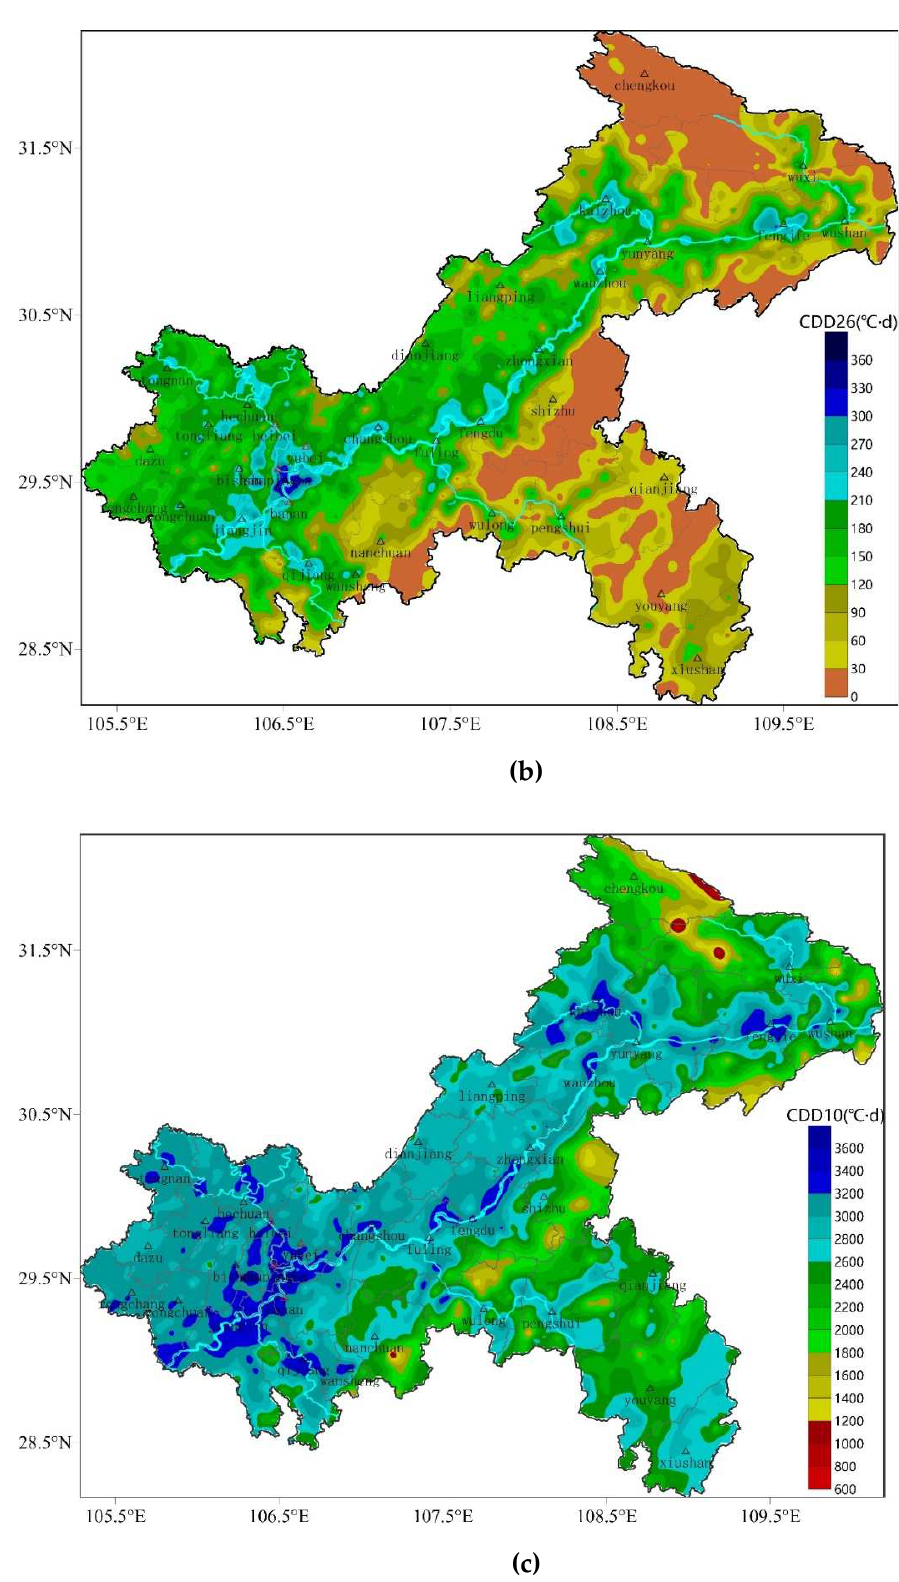
Figure 2. Refined spatial distribution of HDD18 ( a ), CDD26 ( b ), and CDD10 ( c ) in Chongqing (unit: °C·d; the 34 small triangles in the figure indicate the national meteorological stations, among which the 4 small red triangles indicate the national meteorological stations in the main urban area of Chongqing, while the regional meteorological stations are too dense to be marked on the map).